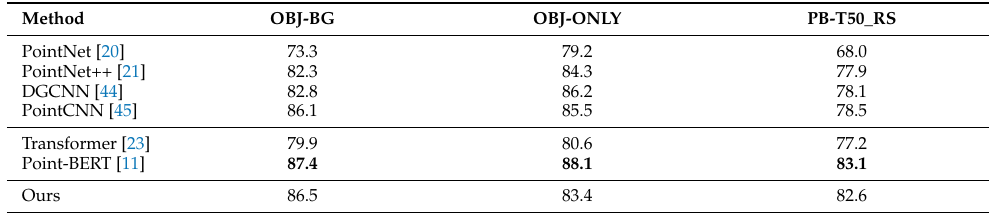
Table 7. Object classification on ScanObjectNN. Three main variants were considered: object only, object with background, and the hardest perturbed variant (PB_T50_RS variant). The bold denotes the best